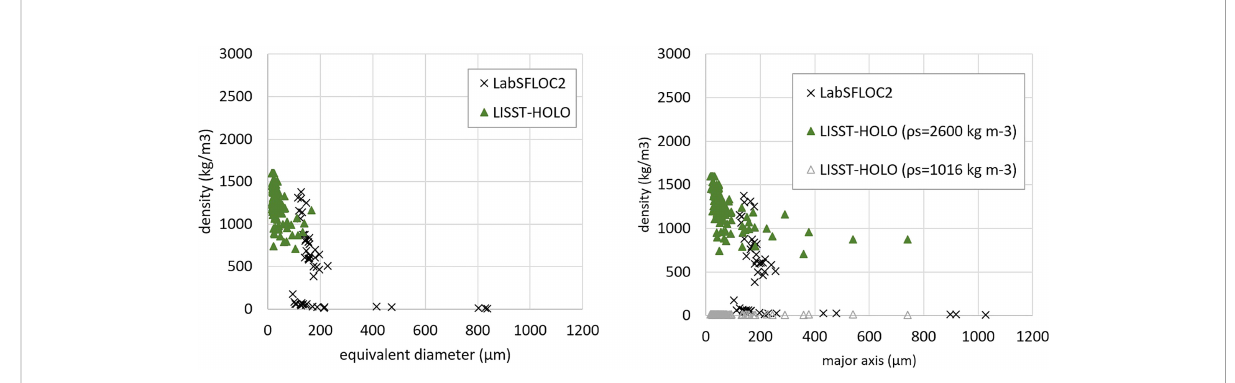
FIGURE 4 Density of particles as function of size, determined by LabSFLOC2 and LISST-HOLO measurements for survey time 10:40 (GMT). Left fi gure: as function of particle equivalent diameter, right fi gure: as function of particle major axis. See text for details about the derivation of the density from LISST-HOLO data.